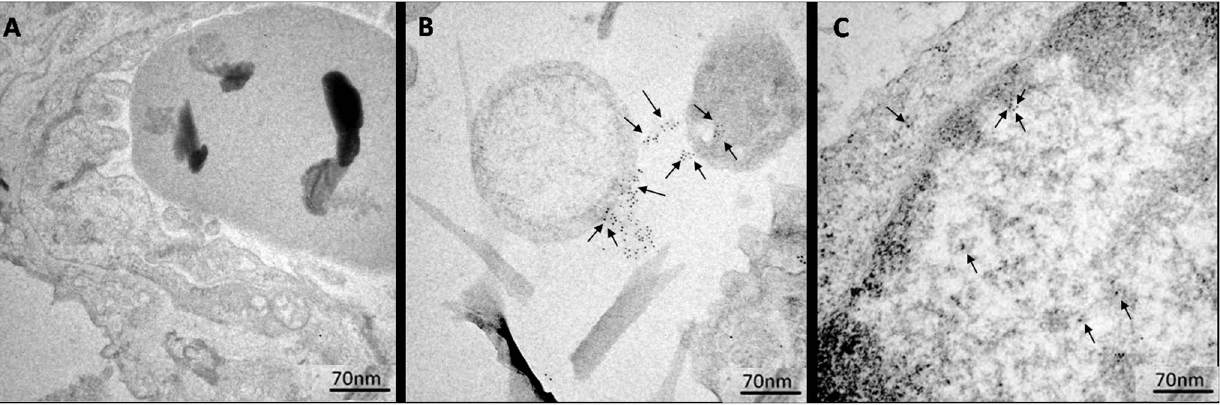
Figure 6. IEM detection of the 14-3-3 protein in P.brasiliensis yeast cells during acute mouse infection (B) and chronic mouse infection (C). Control: uninfected mice (A). The arrows indicate the gold particles, demonstrating the sub-cellular localization of this protein.